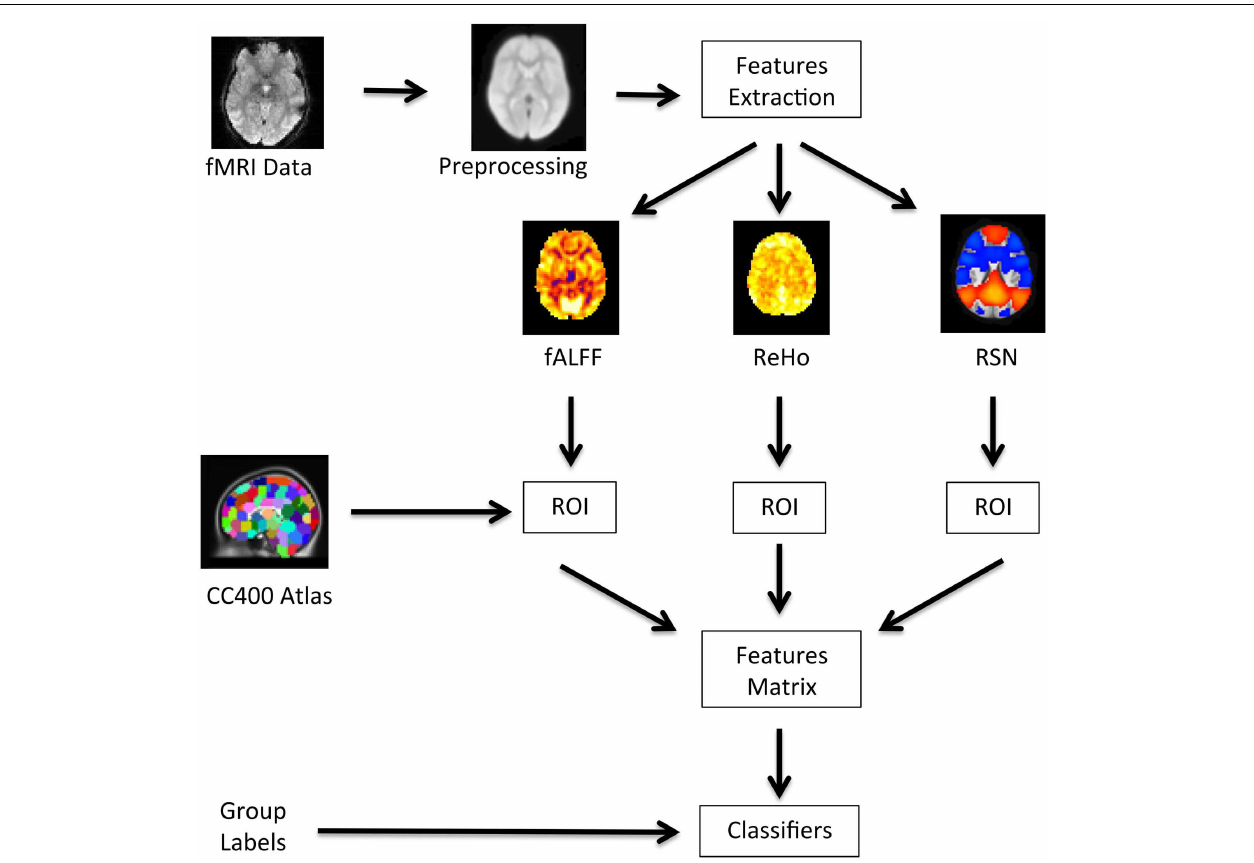
of these maps within each ROI are calculated using the CC400 atlas; the data is then organized in a features matrix which is then input to the classifiers.